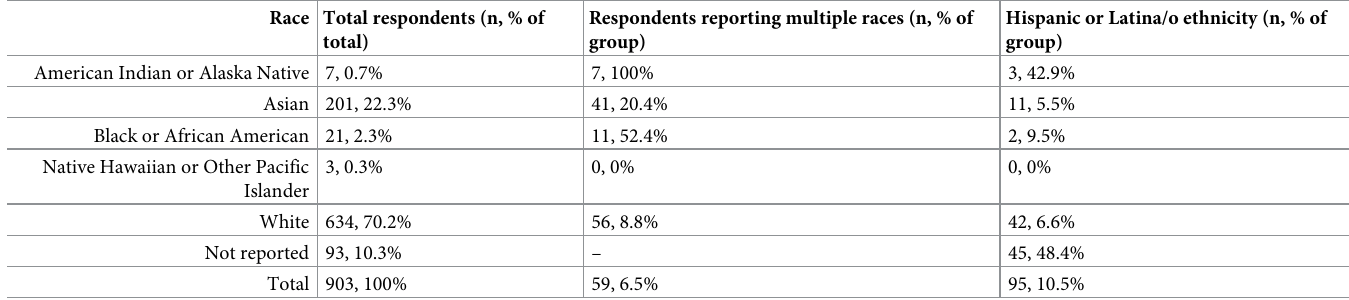
Table 3. Race and ethnicity of exit survey respondents (n =